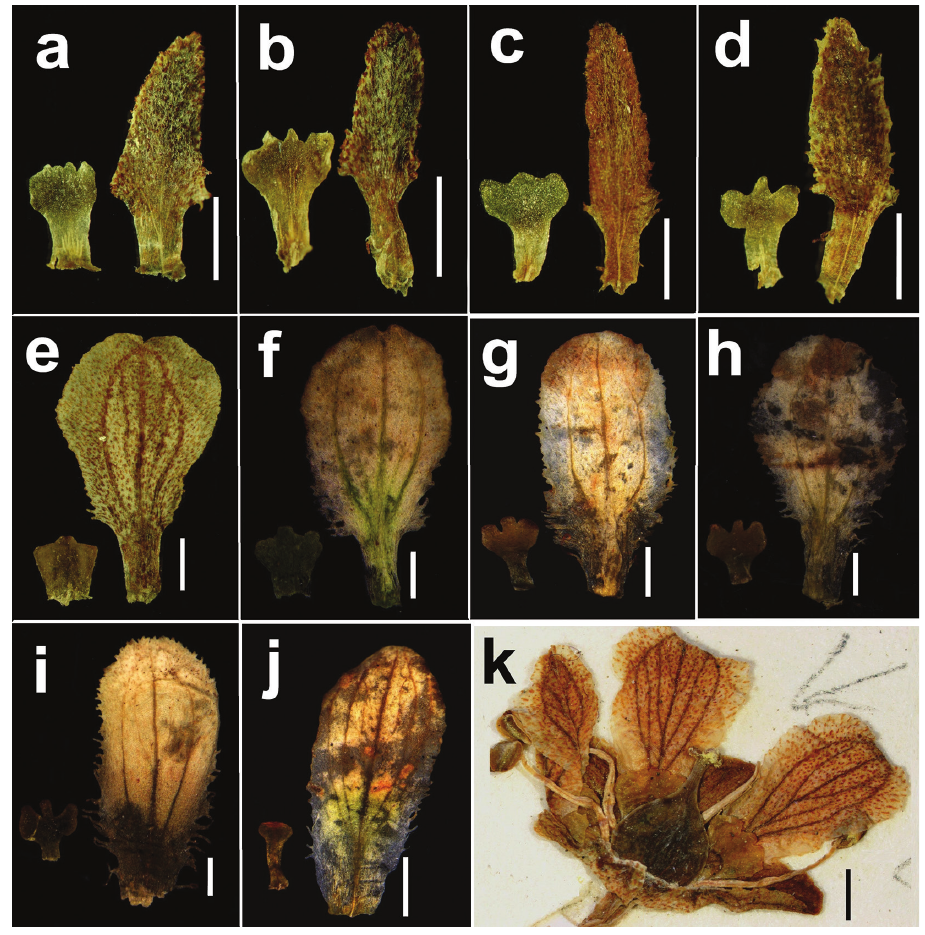
Figure 2. Morphology of the petals and staminodes in Parnassia . P. lanceolata var. oblongipetala ( a, b Jinshajinag Exped. 6105 , the holotype), P. yunnanensis ( c, d T.T. Yu 7429 ), P. cacuminum ( e T.T. Yu 12254 f Y.M. Shu et al. sz286 ), P. kangdingensis ( g, h Y.M. Shu et al. sw365 ), P. venusta ( i Y.M. Shu et al. sw365 ), P. cacuminum var. longistipitata ( j Y.M. Shu et al. sw459 ), P. degeensis ( k Y.W. Tsui 4997 , the holotype). Scale bar = 1